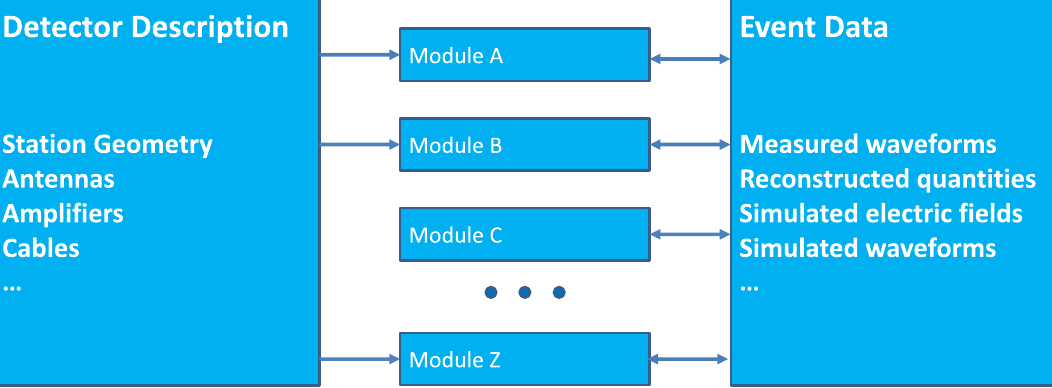
Fig. 1 The three principal parts of NuRadioReco. Detector description and event data are strictly separated. The data-analysis is carried out through fully separated processing